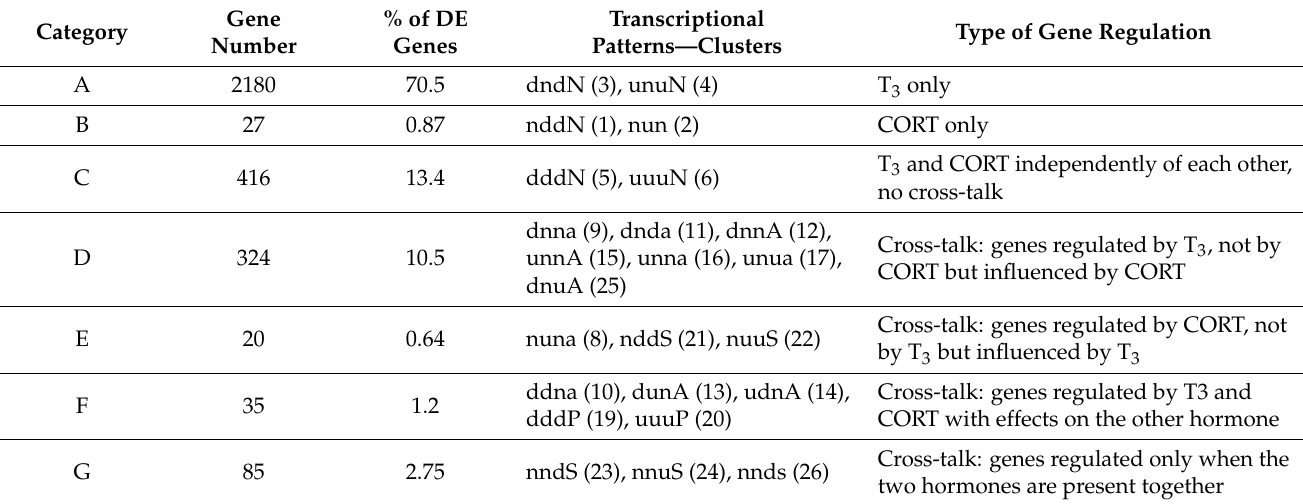
Table 1. Transcriptional profiles of differentially expressed